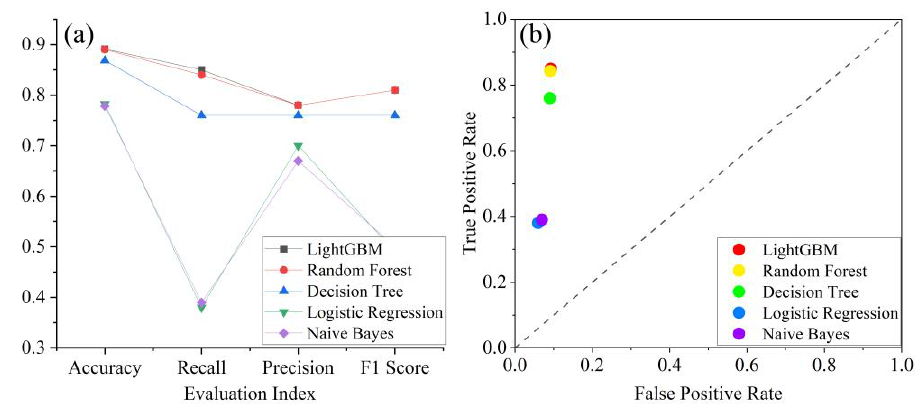
Figure 6. Performance comparison of classification methods. Subplot ( a ) shows the accuracy, recall, precision, and F1 score of several machine learning methods. Subplot ( b ) shows the FPR and TPR classified by several methods with a classification threshold of 0.5.